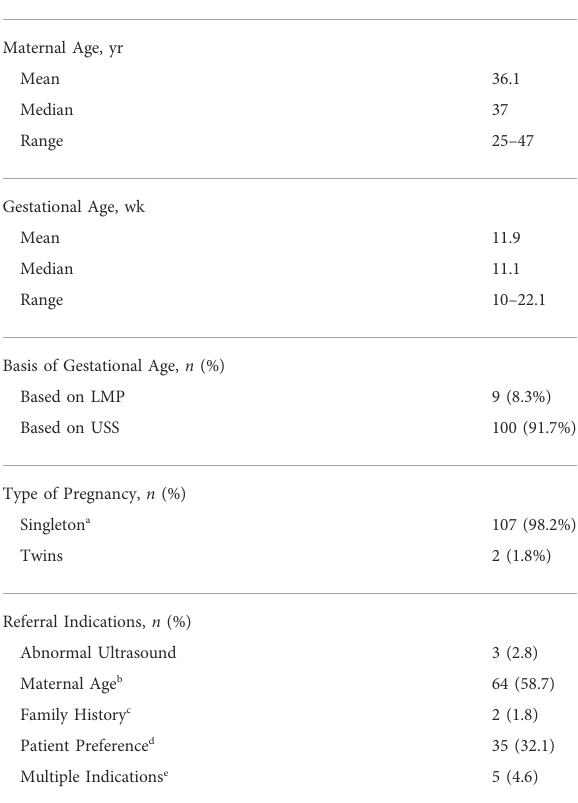
TABLE 1 Demographics of the study cohort ( n =